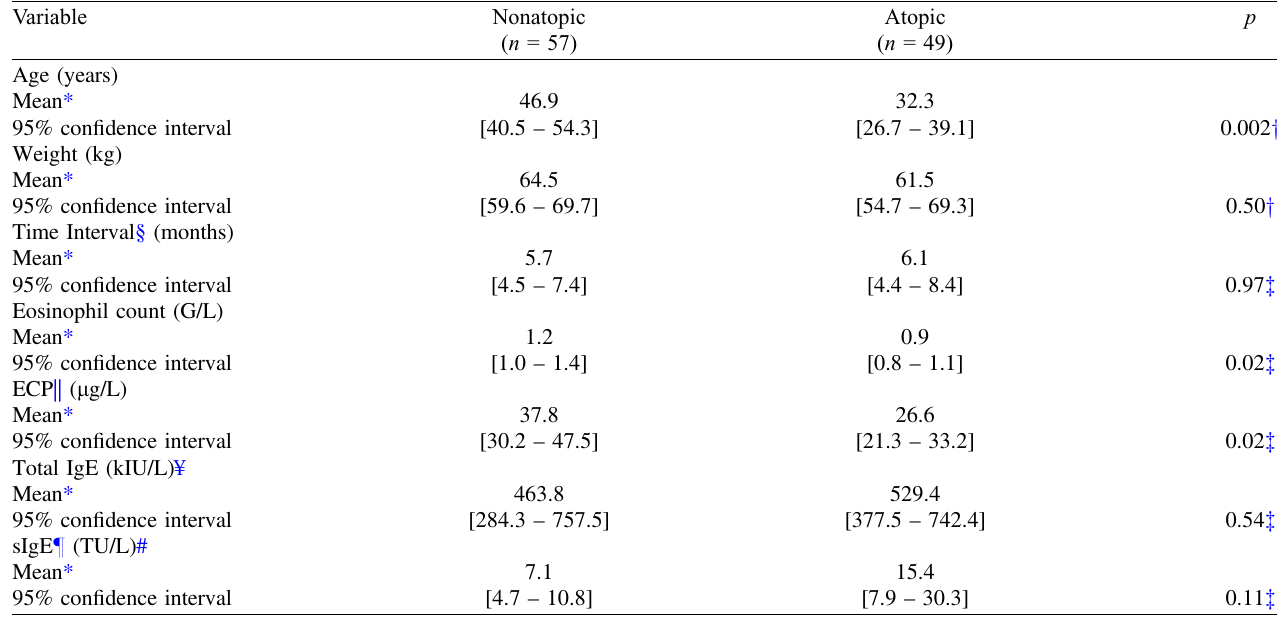
Table 2. Bivariate analysis of demographic, clinical and laboratory continuous variables recorded in 106 toxocariasis